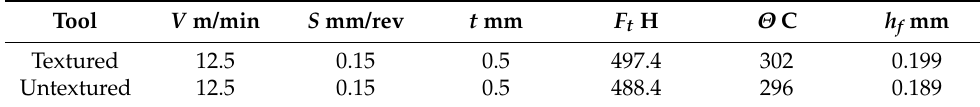
Table 12. Results of additional experiment processing